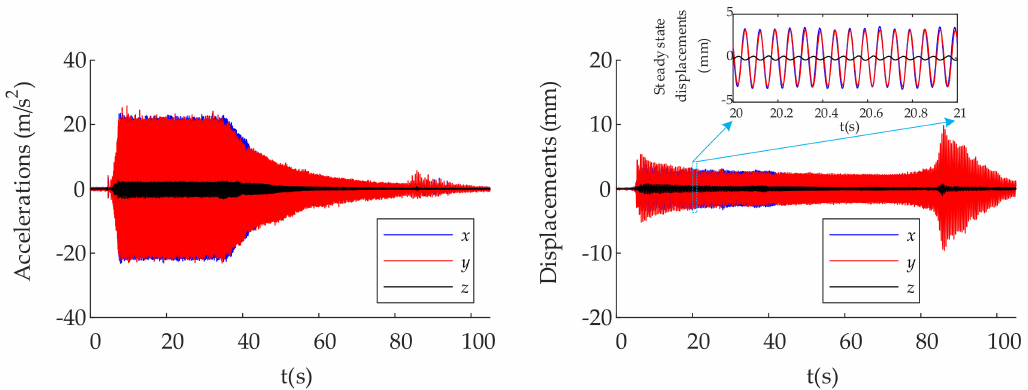
Figure 9. Acceleration and displacement curves in the x , y , and z directions of spring seat 2 under normal conditions, including the steady state displacement curves during 20–21